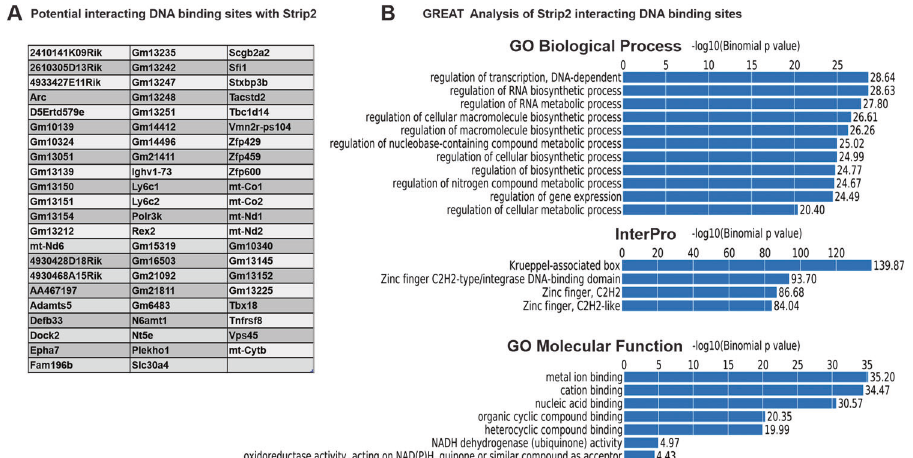
Fig. 1 DNA motif associated with Strip2. A List of active binding sites of strip2 according to mm10 coordinates. B Top Gene Ontology Terms Signi fi cantly Enriched in Strip2 active binding sites according to Genomic Regions Enrichment of Annotations Tool (GREAT) analysis. Interestingly, the InterPro analysis indicated that Strip2 interacts with the DNA regions of several Krueppel-associated box (KRAB) zinc- fi nger proteins (ZFPs) which are known repressors of